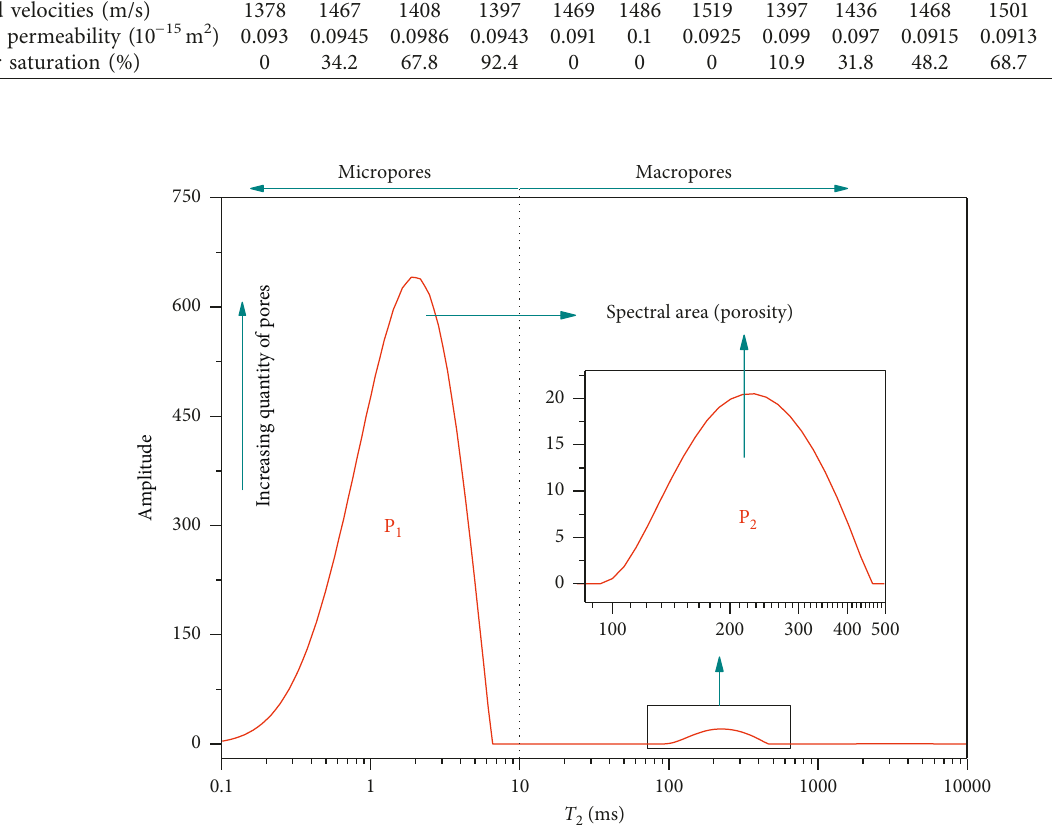
Figure 1: T 2 distribution curve of coal